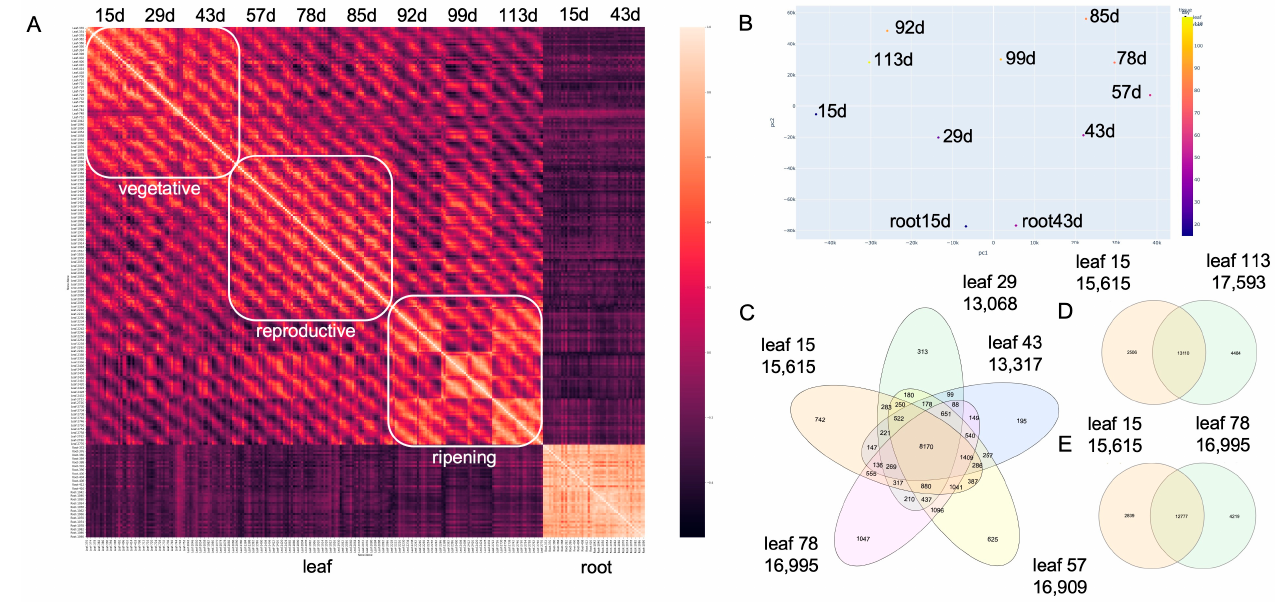
Figure 1. DIURNAL analysis of Developmental time course in rice. ( A ) Correlation matrix of the full rice developmental time course in order from 15 to 113 day (d) and from Zeitgeber Time 6 (ZT6) to ZT54 from leaf, and then 15 and 43 d from root; ( B ) Multidimensional scaling plot of the time courses; ( C ) Overlap of cycling genes from 15 to 78 d spanning vegetative and reproductive phases; ( D ) Venn diagram of leaf 15 d versus leaf 29 d; ( E ) Venn diagram of leaf 15 d versus leaf 113 d.